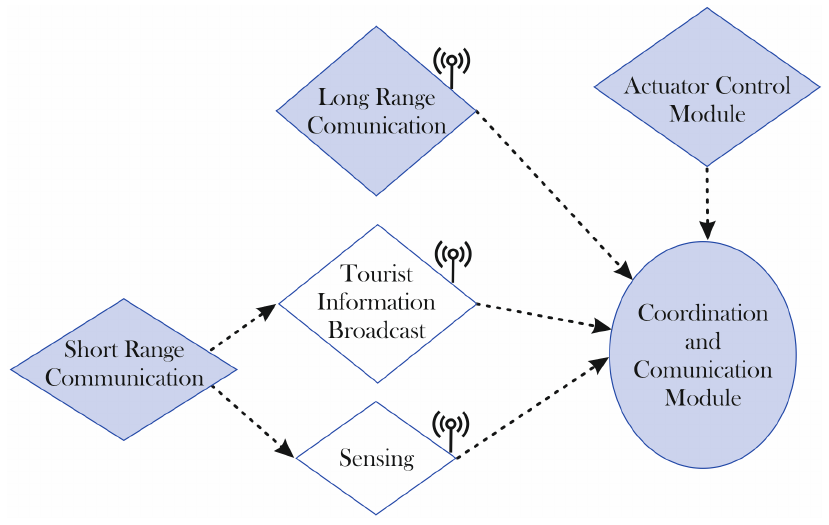
Figure 4. Block diagram for “Local Node Gateway”.